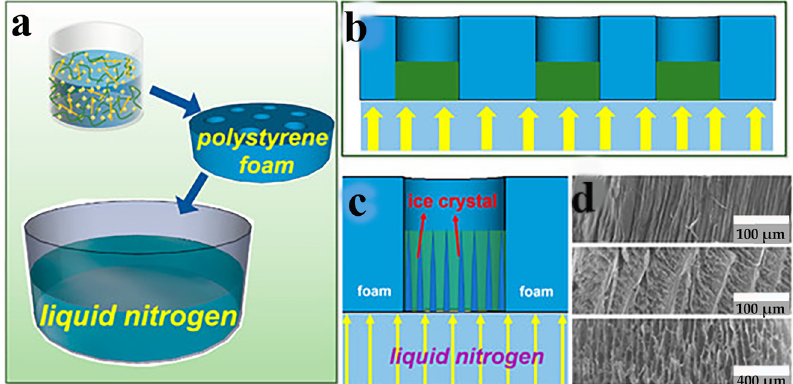
Figure 2. ( a – c ) A directional freeze-drying experimental procedure. ( d ) Morphological observation of aerogel [79] by Jiajia Li, used under CCBY/Cropped from the original.